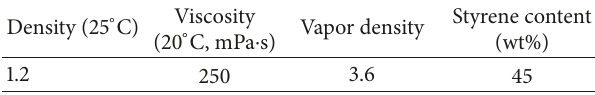
Table 1: Properties of vinyl ester resin.